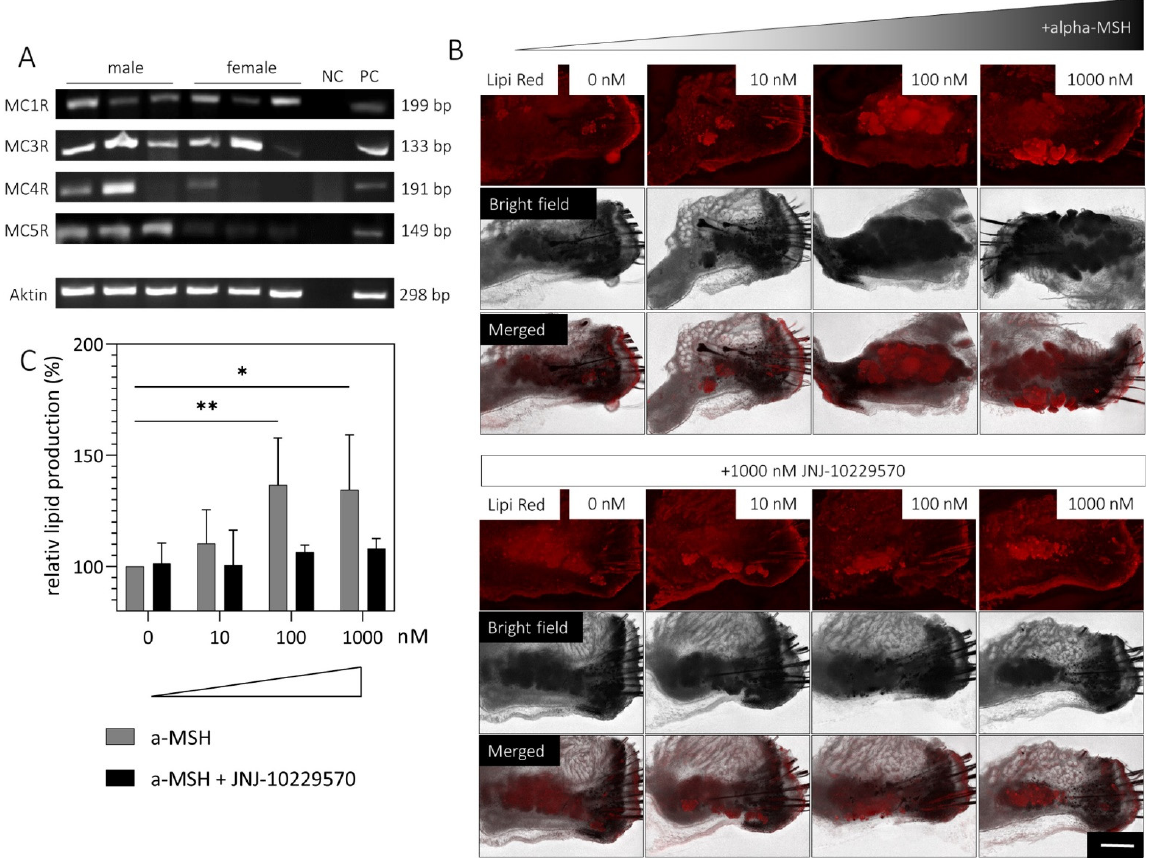
Figure 5. Influence of a melanocortin receptor (MCR) agonist ( α -MSH) and MCR antagonist (JNJ- 10229570) on lipid production in mouse meibomian gland (mMG) organotypic slice culture (OSC). RT-PCR detection of MC1R , MC3R , MC4R and MC5R mRNA in male and female mMG from three different mice ( A ). Representative pictures of lipid droplets visualized by Lipi Red staining of OSCs treated with medium containing up to 1000 nM α -MSH with/without 1000 nM JNJ-10229570 for 1 day ( B ). Lipid production increases significantly with the addition of 100 nM and 1000 nM α -MSH, whereas this effect is absent when JNJ-10229570 is added ( C ). Data are n = 4, mean ± SD, NC = negative control, PC = positive control ( mouse brain). Scale bar: 200 µm * p ≤ 0.05, ** p ≤ 0.01.